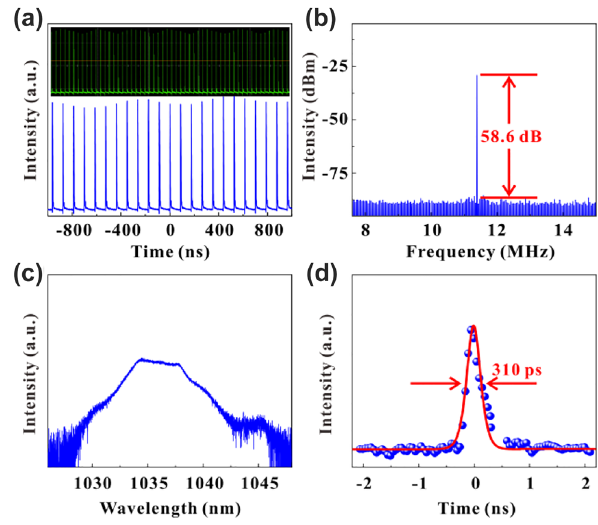
Figure 6: Experimental results of a 1 µm mode-locked fi ber laser. (a) The pulse sequence displayed on the oscilloscope. (b) The RF spectrum. (c) Spectral diagram. (d) Single-pulse